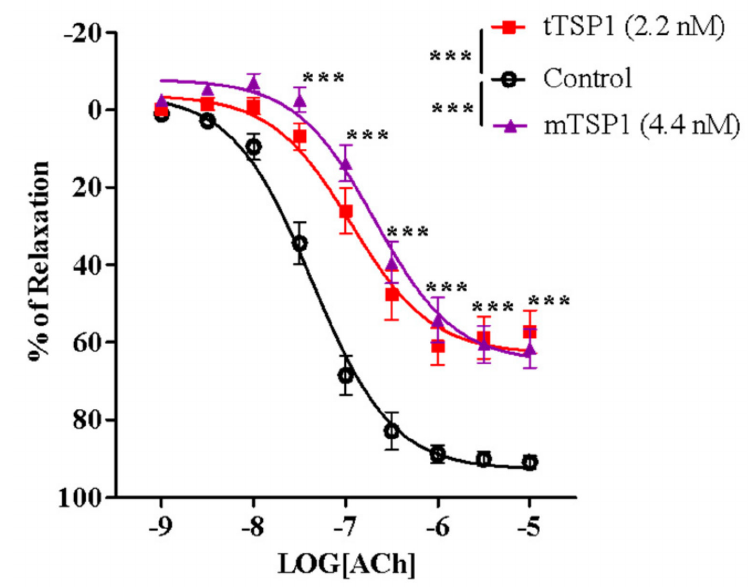
Figure 3. Trimeric TSP1 (tTSP1) at 2.2 nM and monomeric TSP1 (mTSP1) at 4.4 nM showed significant inhibition on vasodilation to the same extent (two-way ANOVA followed by a Bonferroni posthoc test; n = 6, *** p < 0.0001, mTSP1 or tTSP1 vs. control; p > 0.05, mTSP1 vs. tTSP1). TSP1, in both conformations, inhibited endothelium-dependent vasodilation stimulated by acetylcholine, from 30 nM to 10 µ M ( n = 6, *** p < 0.0001, mTSP1 or tTSP1 vs. control; p > 0.05, mTSP1 vs. tTSP1). Table 1. Potency of acetylcholine, measured in EC 50 (mean ± SEM, nM), in recombinant human CD47 peptide (rh-CD47p) pretreatment and post-treatment cohorts. Fold of Shift vs. Fold of Shift Cohort EC 50 Control